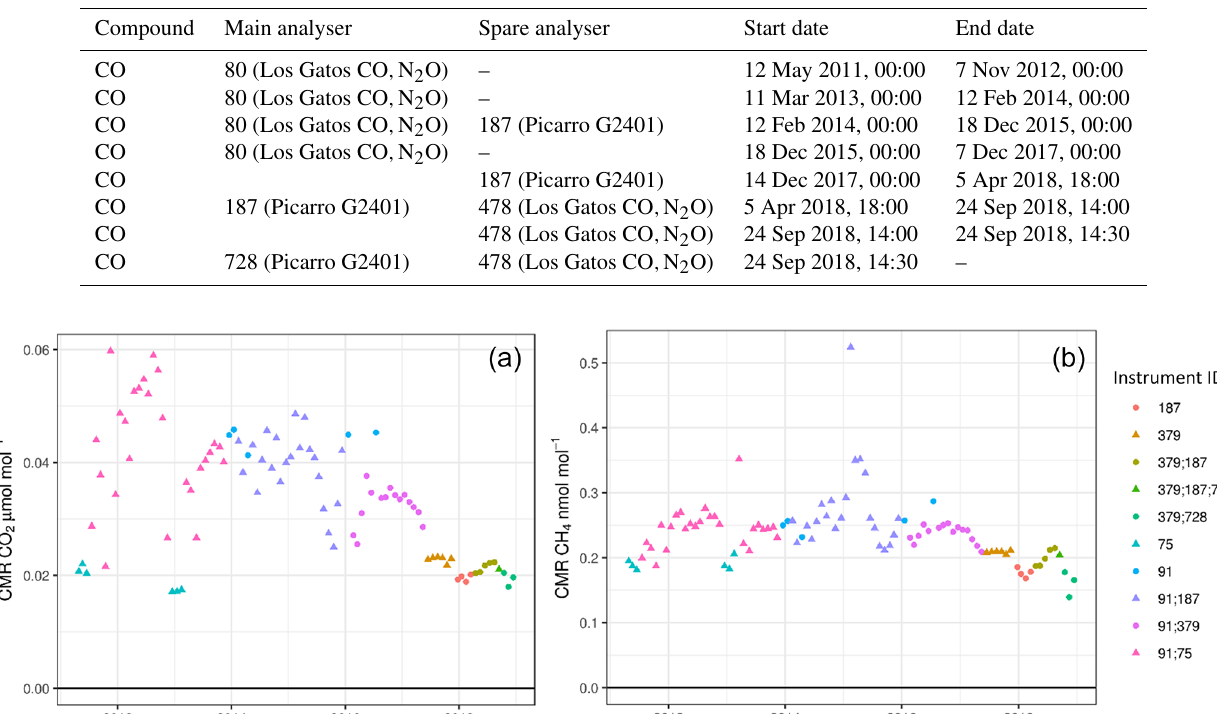
Figure 6. Monthly mean continuous measurement repeatability (CMR) field equivalent for CO 2 (a) and CH 4 (b) estimated over time for the different instruments in operation at the OPE station over the 2011–2018 period. The different instruments are shown in colour, and their identifiers are labelled in the key by the right panel. Some months have several instruments running at the station and these are identified with several